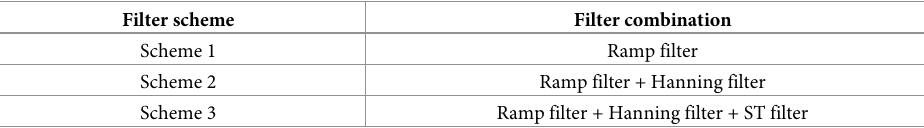
Table 1. The three filter schemes used in the